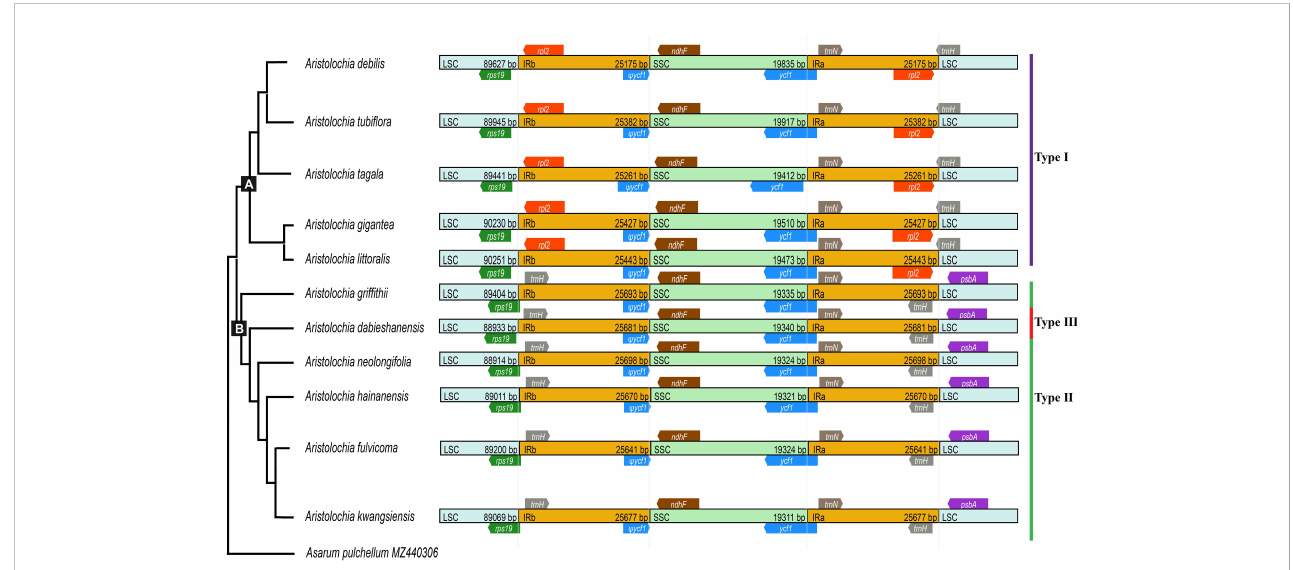
FIGURE 7 Comparison of boundaries of the LSC, SSC, and IR regions among 11 Aristolochia